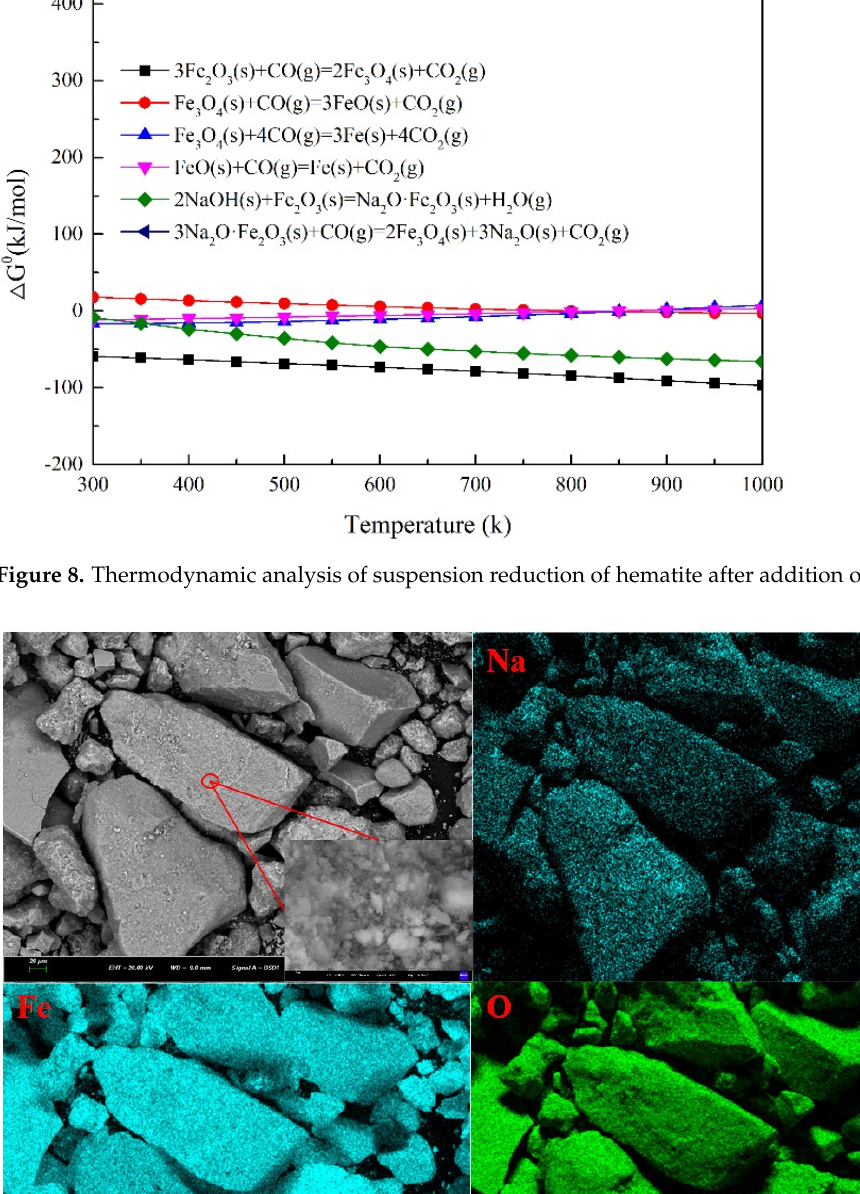
Table 4. Thermodynamic equations of suspension reduction of hematite after addition of NaOH.